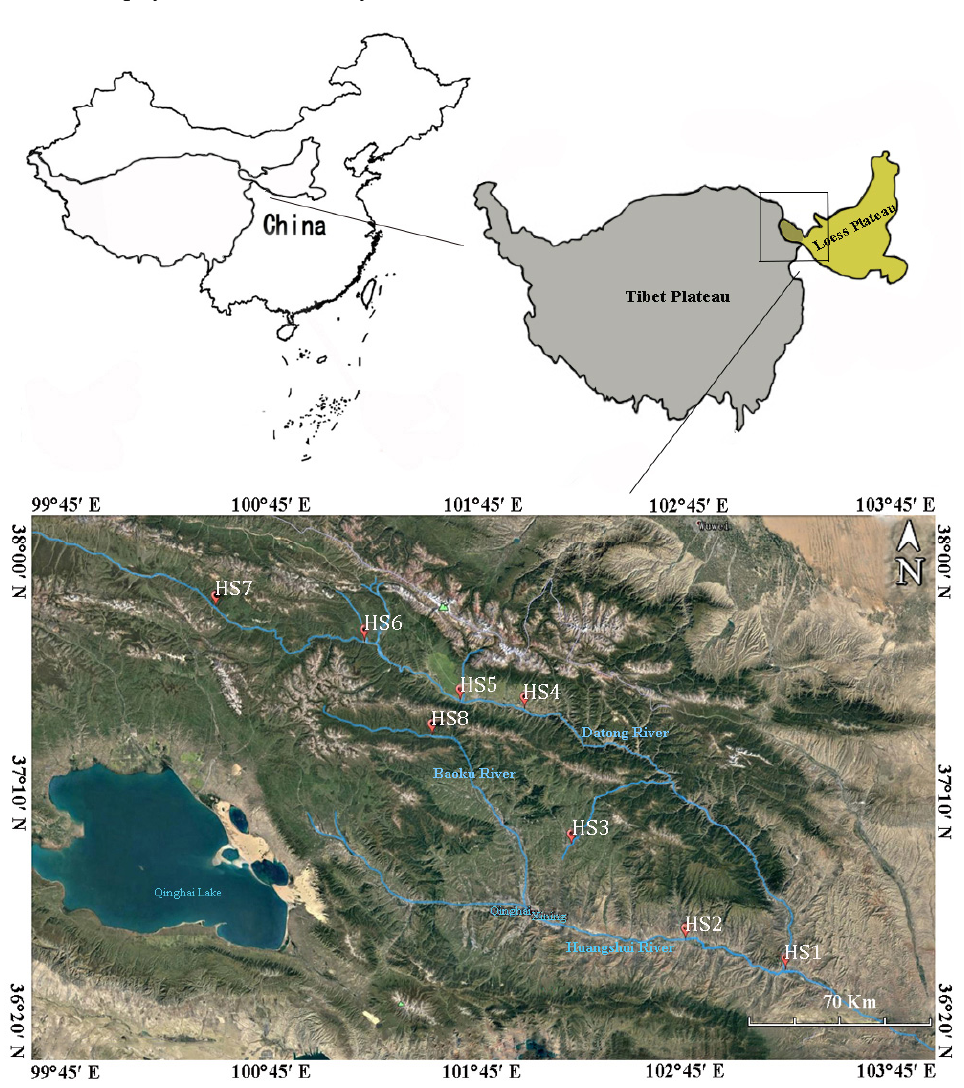
Figure 1. Distribution of the sampling sites in the Huangshui River. Map image and geographical information were cited from Google Earth Pro (version 7.1.8.3036).